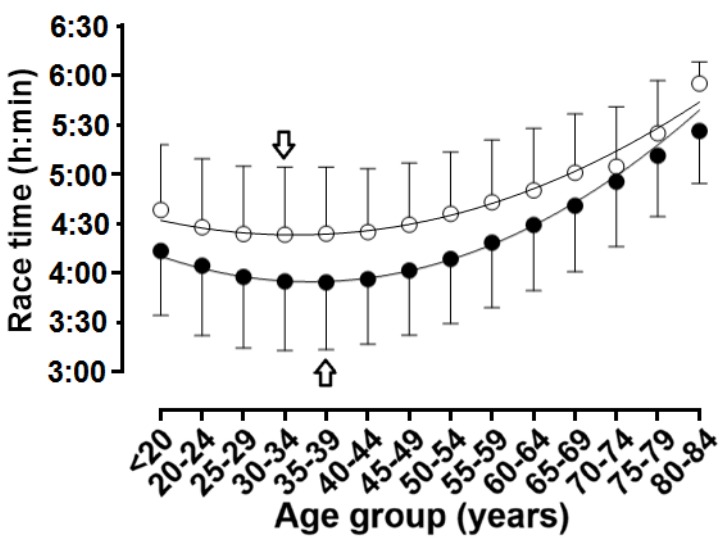
Figure 7. Race time in 5-year age groups. Arrows denote age of peak performance. Error bars represent standard deviations; = women, ⚫ = men.